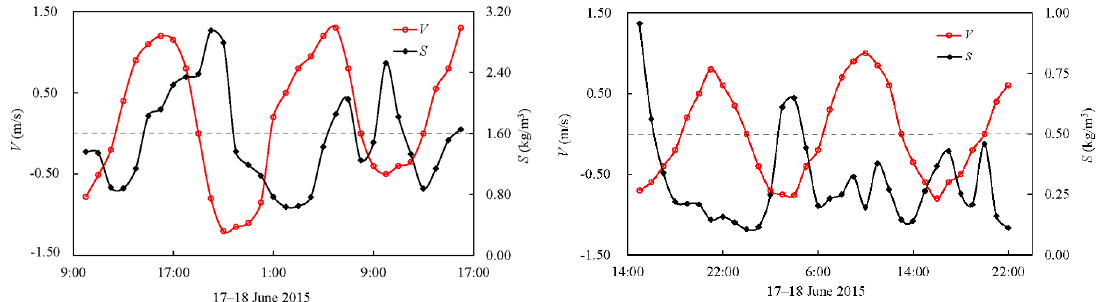
Figure 6. Relationship between V and S at FS5: ( a ) Spring tide; ( b ) Neap tide.